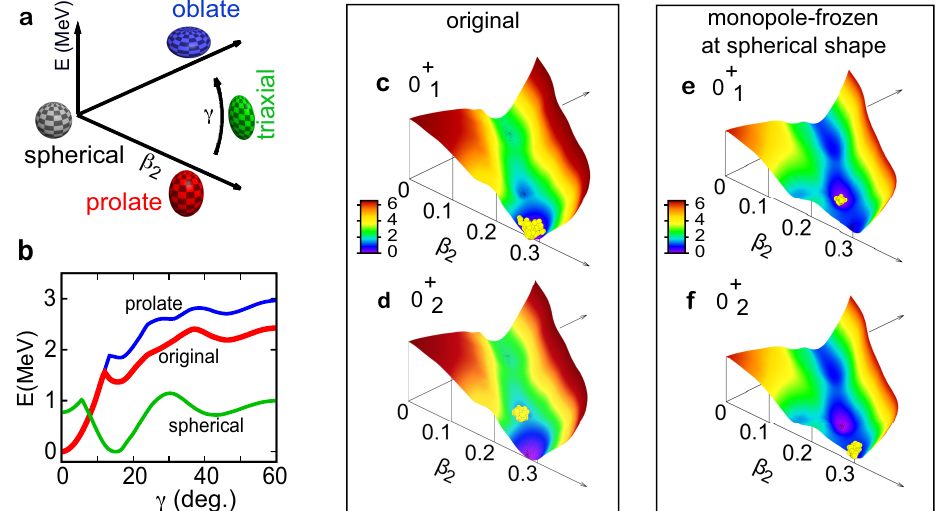
Figure 14. Properties of the 0 + states of 154 Sm. ( a ) Deformation parameters and shapes. ( b ) Lowest 1,2 values of PES for a given γ value for the original case (red) as well as for the prolate (blue) and spherical (green) monopole-frozen cases. ( c – f ) Three-dimensional T-plot in the original and spherical monopole-frozen cases. Based on Figure 3 of